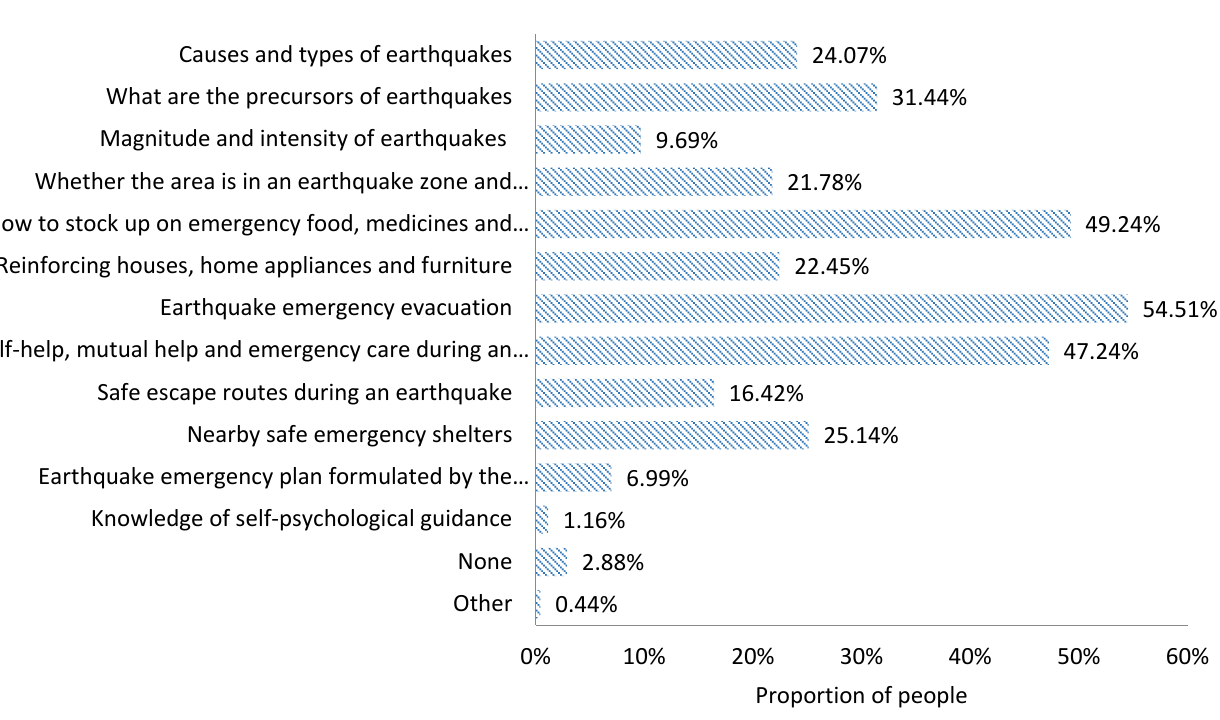
Figure 3. Information actually acquired by the public in the prodromal stage of an earthquake disaster.